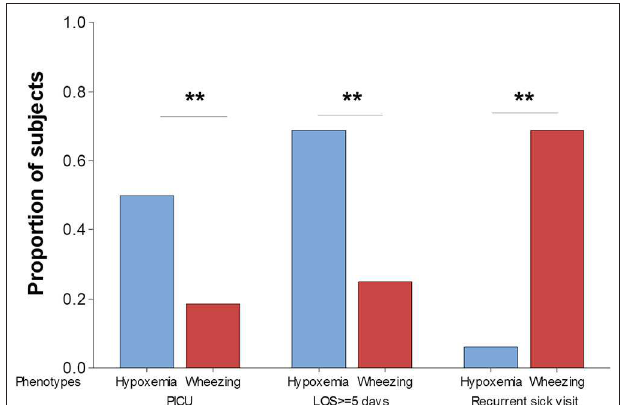
FIGURE 2 | Clinical phenotypes of severe viral respiratory infection using respiratory outcomes. The probability of requiring transferred to pediatric intensive care unit (PICU), prolonged hospitalization defined as ≥ 5 days length of staying (LOS) and recurrent respiratory sick visits after discharge are significantly different in children hypoxemia (blue) vs. wheezing (red) phenotypes. ** p < 0.01.